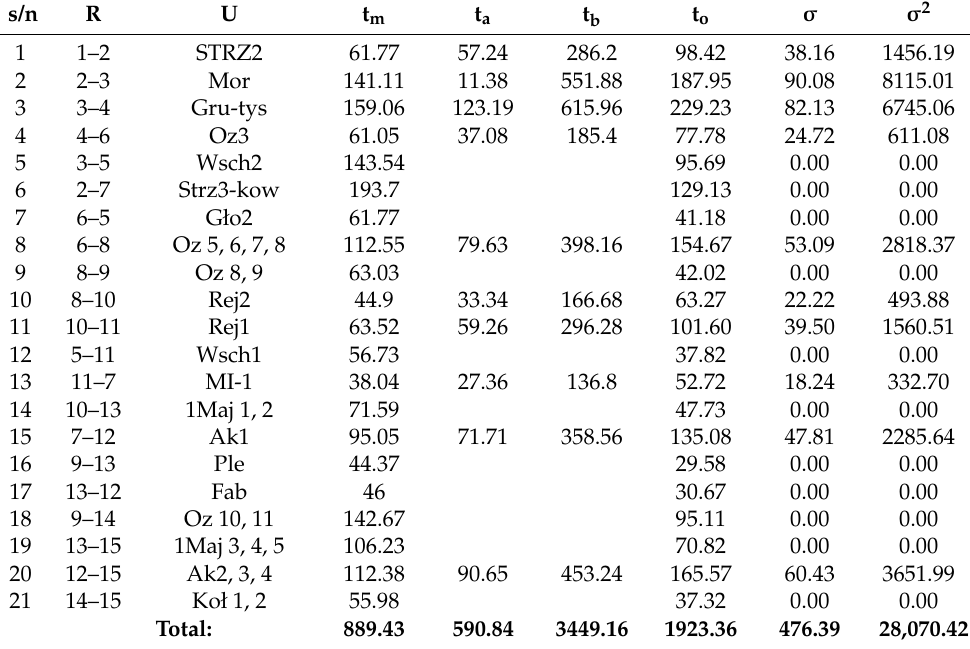
Table 2. Calculation of variances and standard deviations based on the critical path.